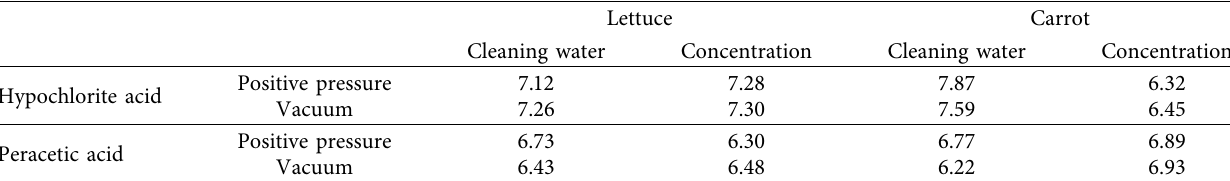
Table 1: pH processing of cleaning water and concentration.